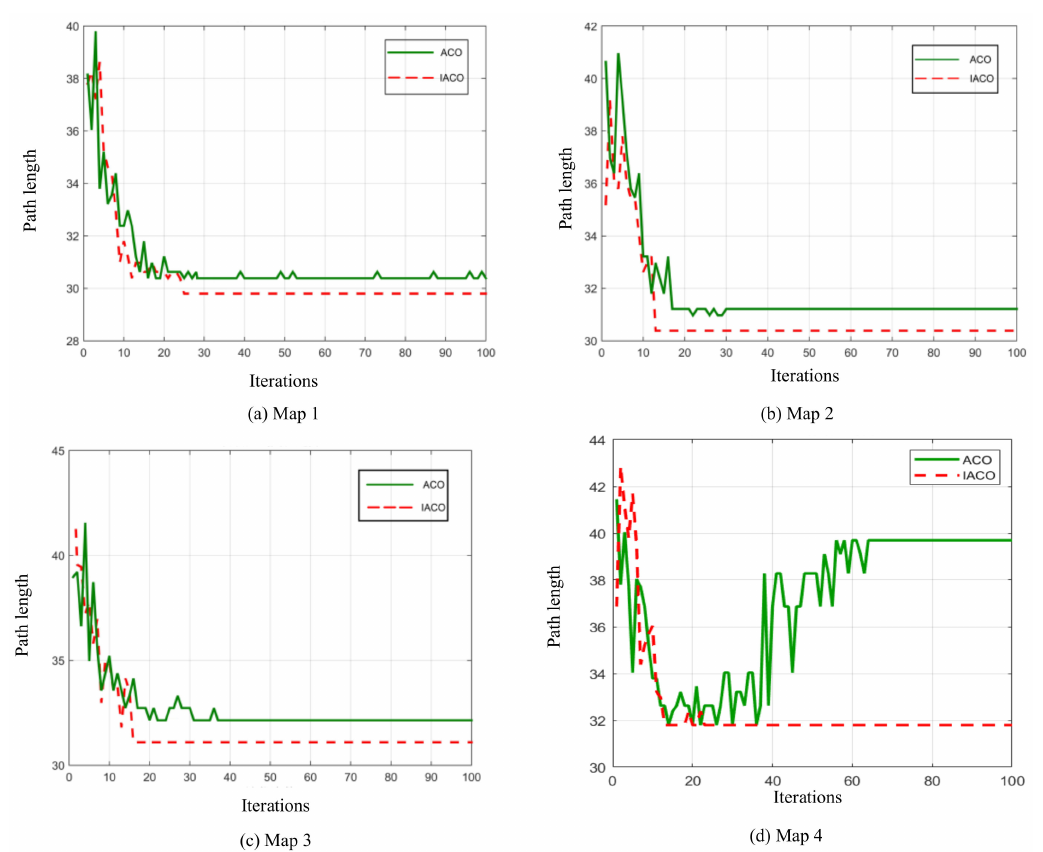
Figure 9. Convergence curves of ACO and